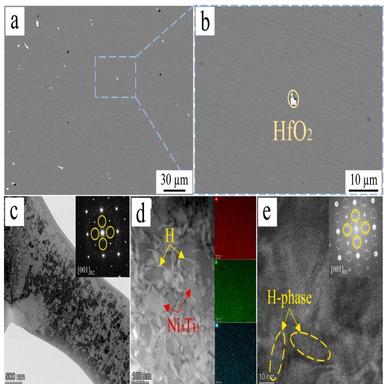
Microscopic morphology of Ni55Ti37Hf8 alloy after heat treatment at 400 ℃ for 100 h, (a)-(b) SEM morphology, (c) Low-magnification TEM morphology, (d) HADDF morphology with corresponding elemental mapping of Ni (red), Ti (green), and Hf (blue), (e) High-resolution morphology of matrix.